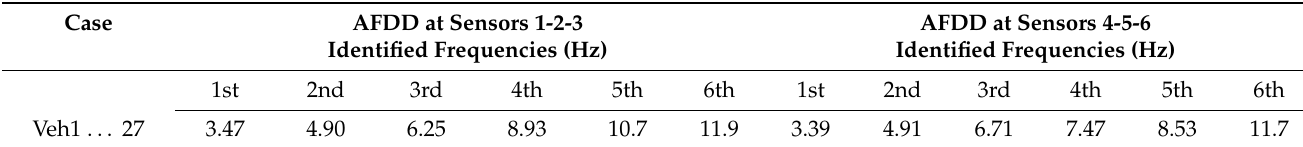
Table 13. Identified frequencies with FDD method in the transverse direction (Y axis).